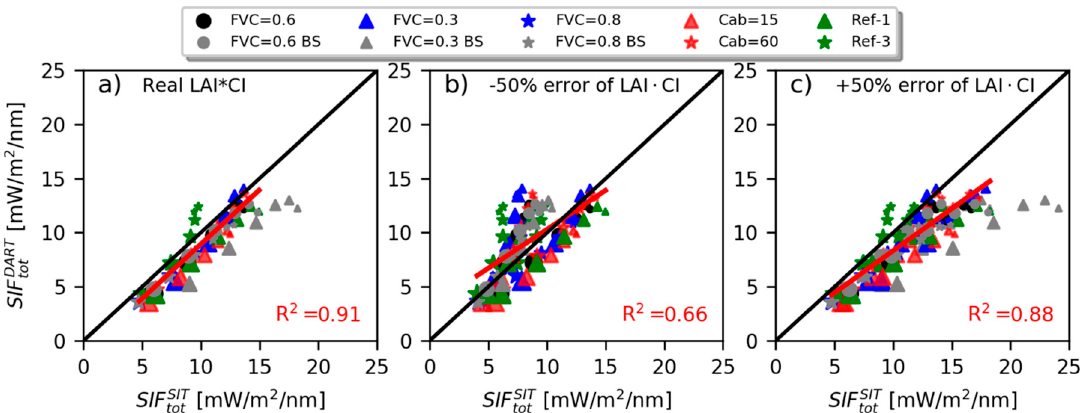
Figure 7. Comparison of the total emitted SIF ( SIF ST ) using di ff erent SIF escape probabilities with DART reference values ( SIF DART ). ( a ) Plot using f esc estimated with ‘real’ LAI*CI; ( b , c ) plots using f esc estimated with additional errors of LAI*CI: − 50% error of LAI*CI for ( b ); +50% error of LAI*CI for ( c ).